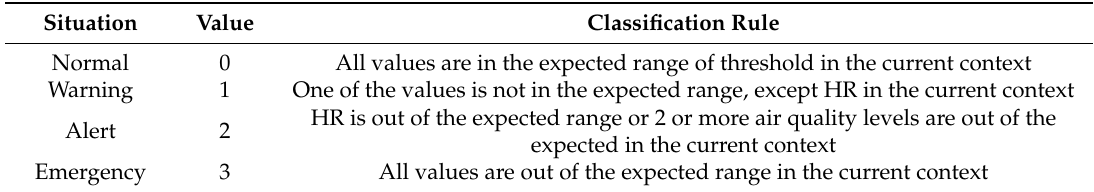
Table 6. The different levels of problem situation based on the human expert